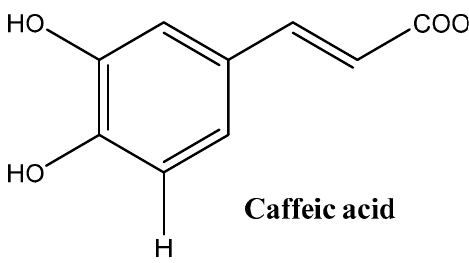
Figure 2. Chemical structure of caffeic acid .